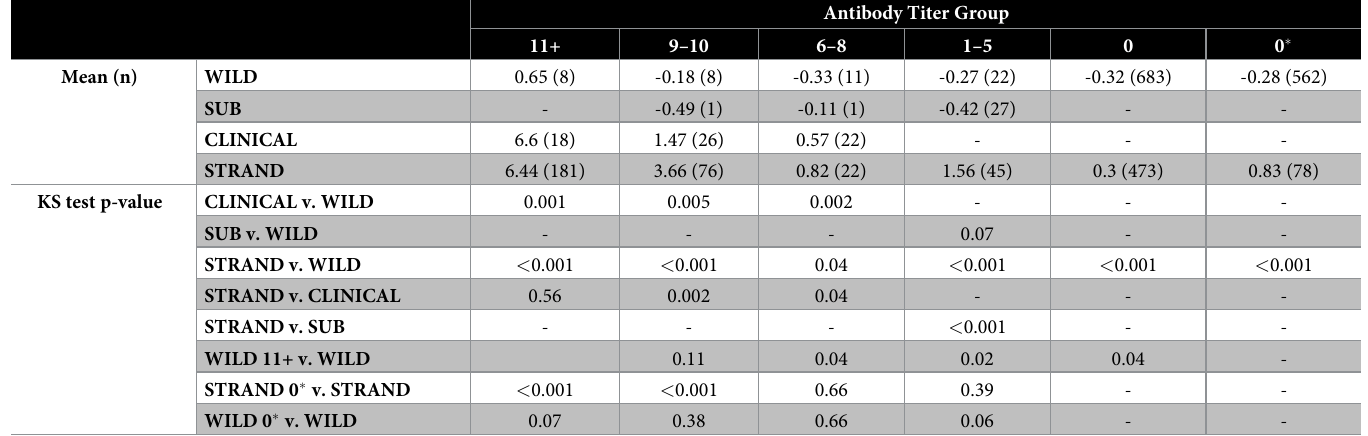
Table 4. Mean renal index scores and sample sizes (n) by antibody titer group for initially clinical (CLINICAL), initially subclinical (SUB), stranded (STRAND) and wild-caught (WILD) animals. Titer group “0” contains all seronegative animals, titer group 0 � contains only non-shedding (i.e. urine PCR negative) seronegative ani- mals. P-values are for two-sided bootstrap Kolmogorov-Smirnov (KS) test comparisons between animal groups of renal index distributions for a given titer. P-values for WILD 11+ v. WILD are for one-sided bootstrap KS test comparisons within the WILD dataset, with the null hypothesis that the renal index distribution for the 11+ titer group will be greater. P-values for STRAND 0 � v. STRAND are for two-sided bootstrap KS test comparisons within the STRAND dataset comparing renal index distribu- tions of seronegative, non-shedding animals with the other titer